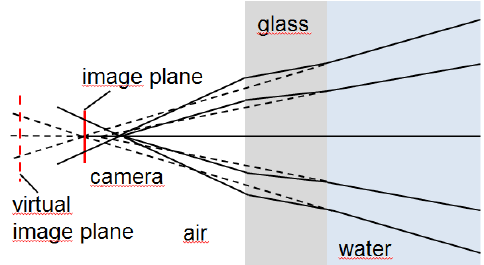
Figure 6. Ray directions with refraction effects using planar glass